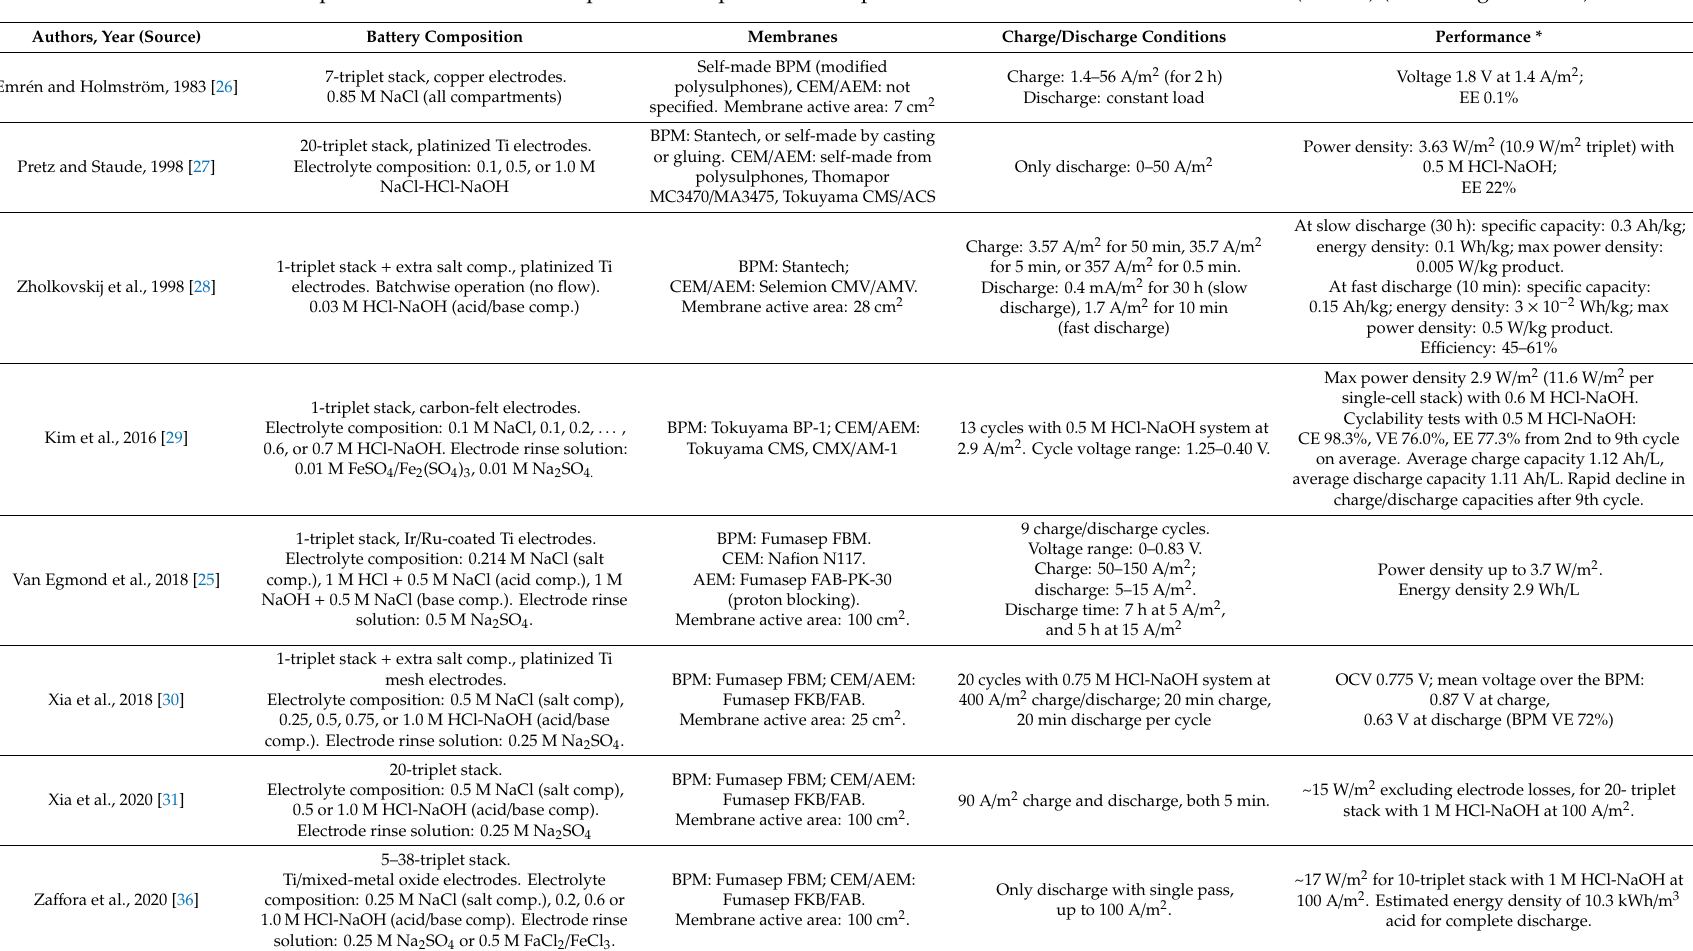
Table 1. Overview of experimental conditions and performance parameters of previous works on acid–base flow batteries (ABFBs) (chronological order). Authors, Year